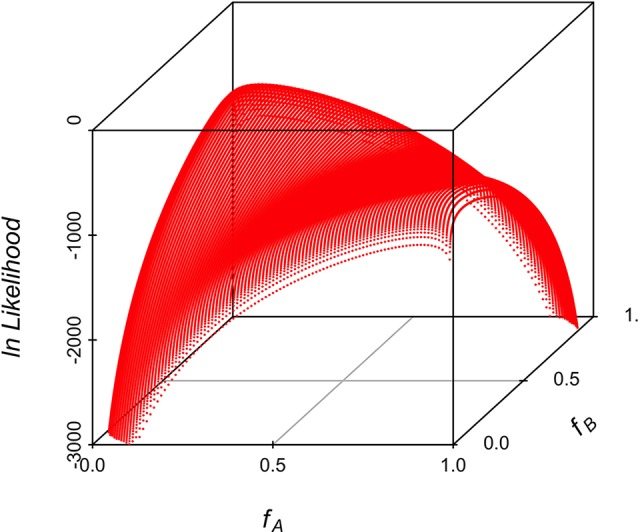
3D scatterplot of the natural logarithm of the likelihood along the allele frequencies in the two parental populations for one example illustrating the two maxima corresponding to the allele frequencies of the two parental populations. The simulated allele frequency was 0.1 and 0.9 in the two parental breeds.